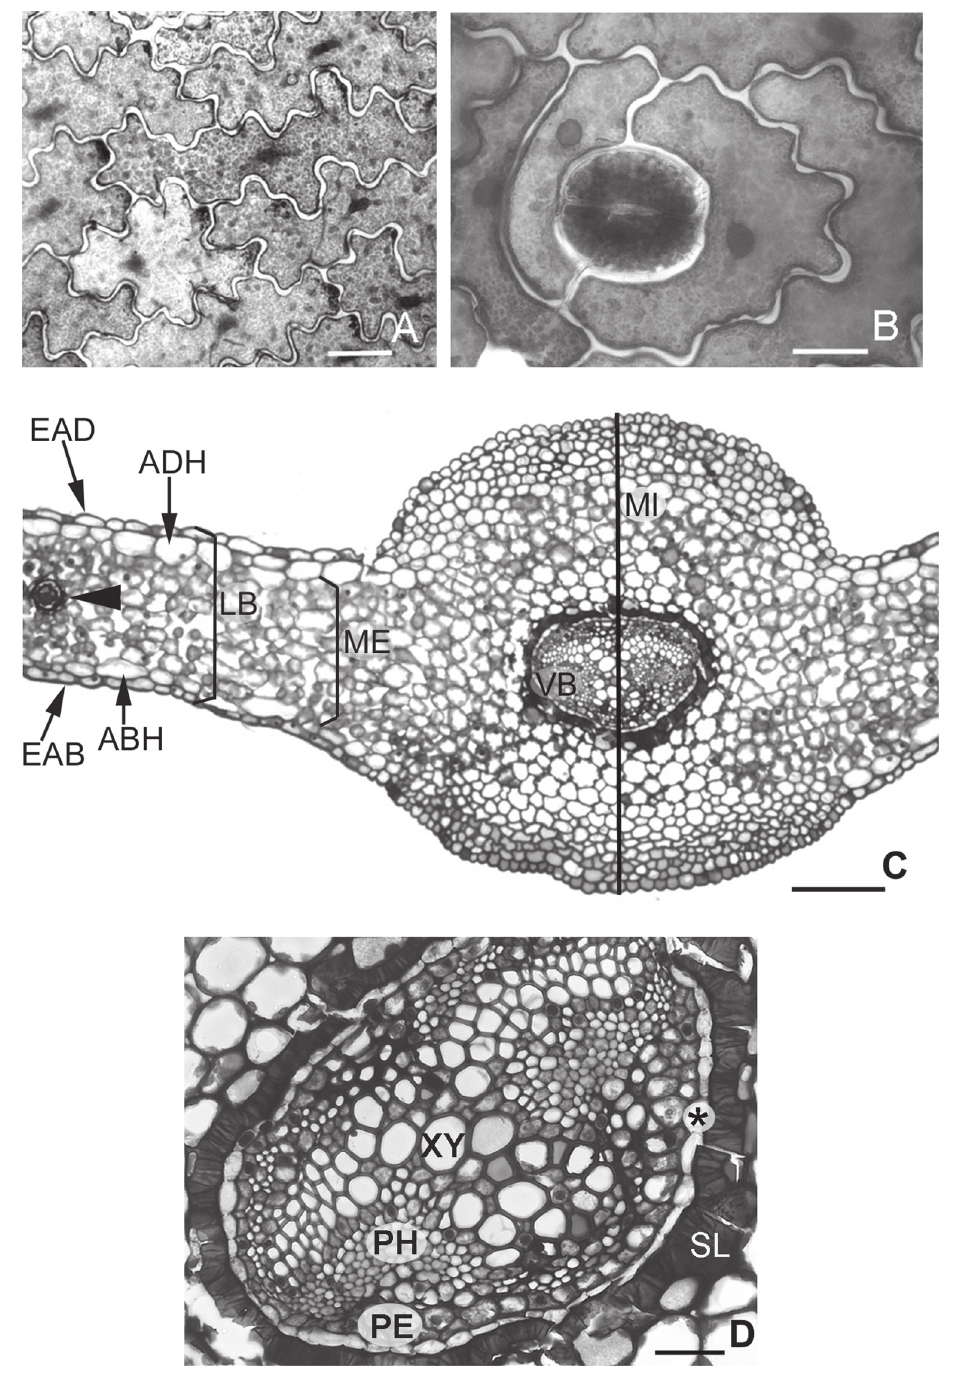
Figure 1 - Leaf sections of Microgramma squamulosa . A. Epidermis adaxial face. Bar = 20 µm. B. Epidermis abaxial face: anomocytic stomatal complex. Bar = 15 µm. C. Leaf blade (LB) in cross-section evidencing: epidermis adaxial face (EAD), epidermis abaxial face (EAB), adaxial hypodermis (ADH), abaxial hypodermis (ABH), mesophyll (ME), midrib (MI) and vascular bundle area (VB and arrowhead). Bar = 100 µm. D. Midrib: detail of sclerified layer (SL), endodermis (*), pericycle (PE), phloem (PH) and xylem (XY). Bar = 10